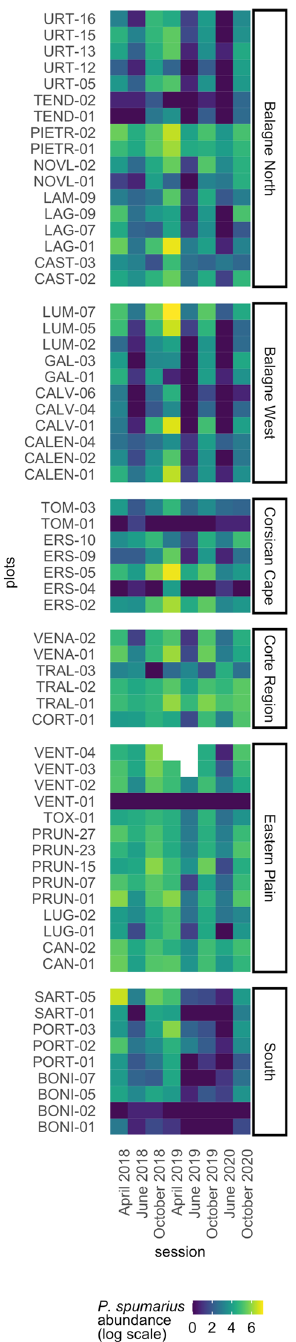
Figure 2. Abundance of P. spumarius and climate data. Spatiotemporal variability of Ps abundance (log scale). Rows show plots and columns show sampling sessions. White cells show NAs (vegetation